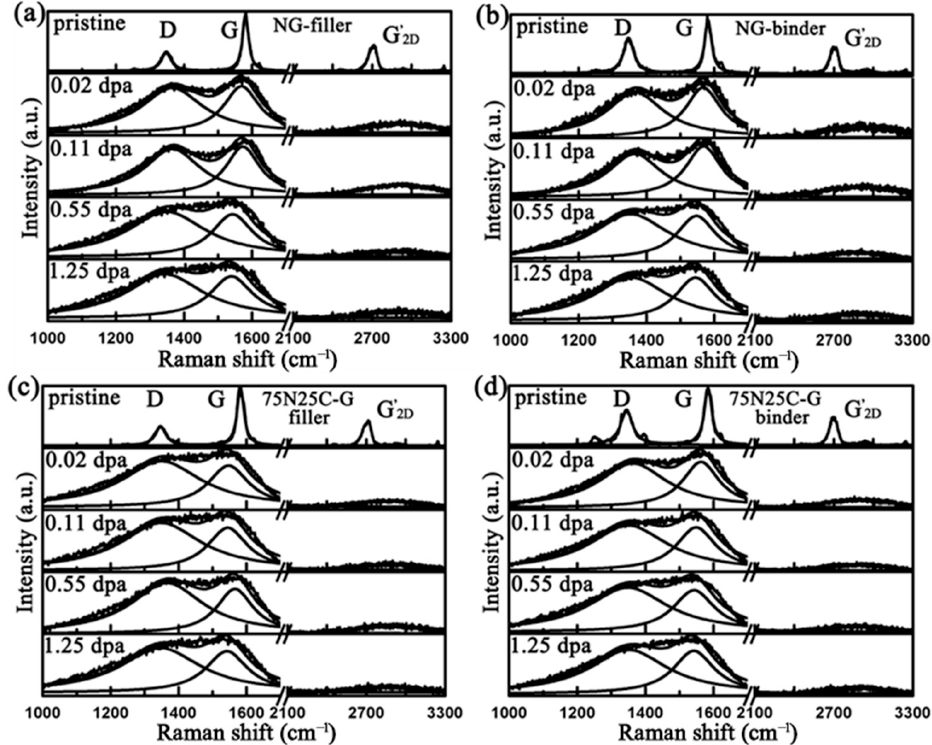
Figure 5. Raman spectra of the filler ( a ) and binder phase ( b ) of NG, filler ( c ) and binder phase ( d ) of 75NG25C-G.